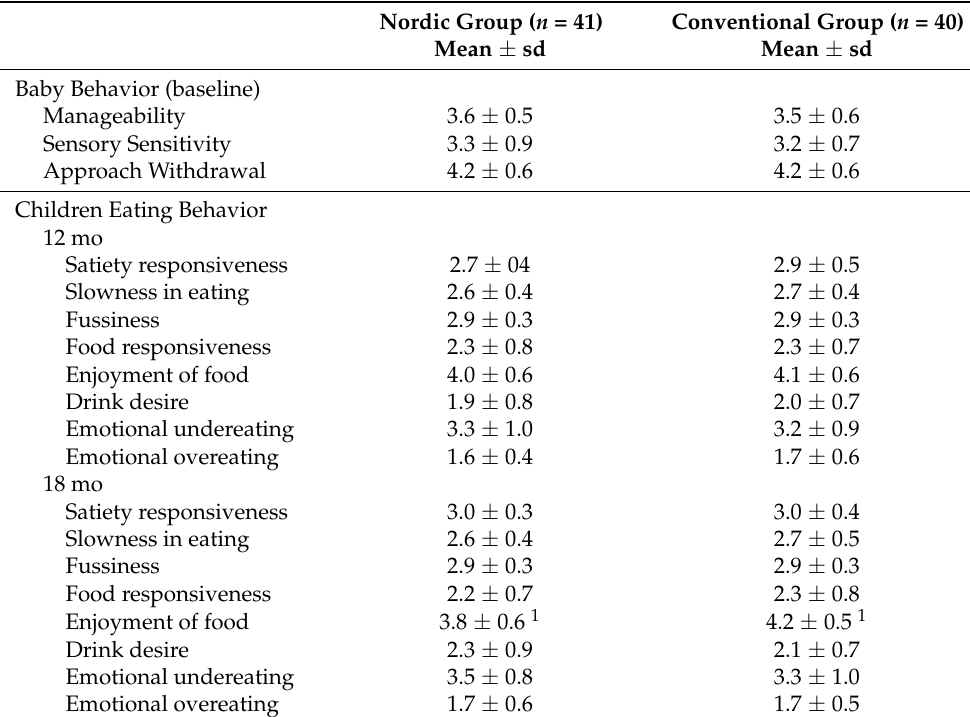
Table 2. Baby behavior questionnaire (BBQ) and children eating behavior questionnaire (CEBQ)